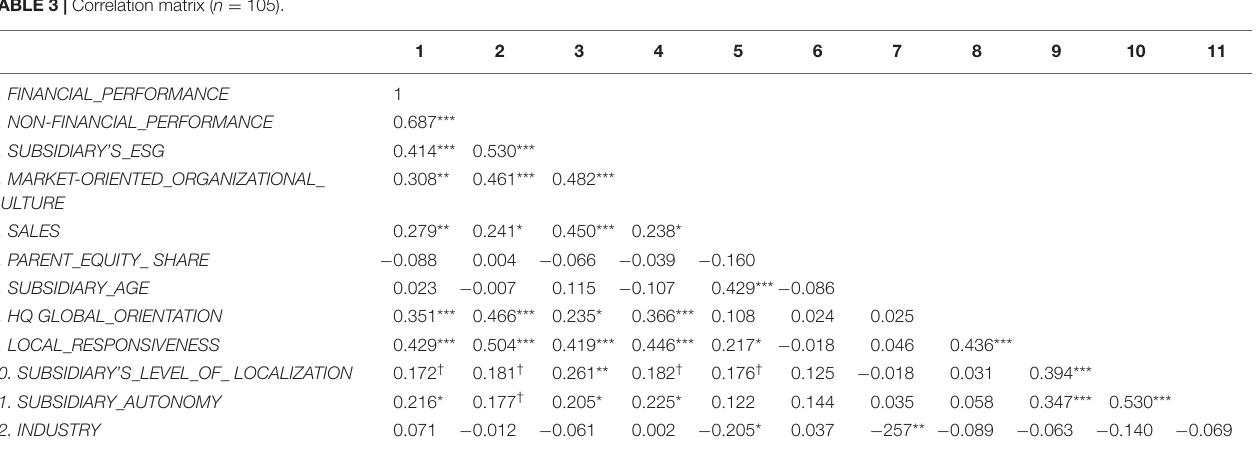
TABLE 3 | Correlation matrix ( n =